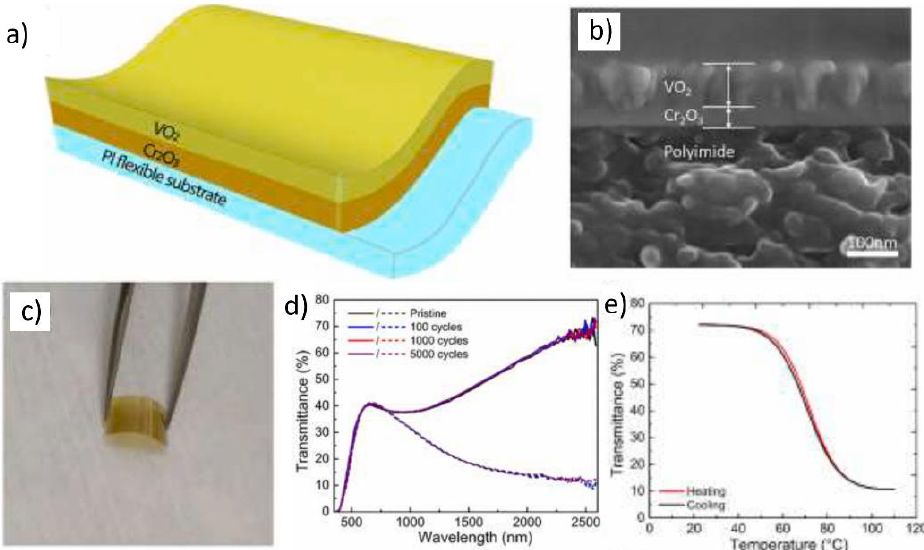
Figure 6. ( a ) Schematic representation and ( b ) cross-sectional scanning electron microscopy image of VO 2 /Cr 2 O 3 /polyimide (PI) film; ( c ) Photograph of flexible VO 2 /Cr 2 O 3 /PI film, ( d ) Ultraviolet–visible–near-IR (NIR) transmittance spectra of flexible VO 2 /Cr 2 O 3 /PI film after multiple bending cycles; ( e ) Temperature-dependent transmittance hysteresis loop (2500 nm) of flexible VO 2 /Cr 2 O 3 /PI film. Reproduced with permission from [94]. Copyright 2021, Elsevier.